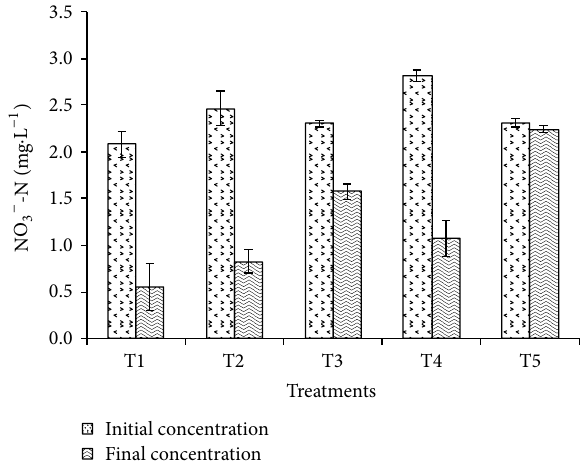
Figure 4: The change of the concentration of NO 3− -N under controlled drainage at jointing-booting stage. The initial and final concentrations are the NO 3 − -N concentration in groundwater at the beginningofsubmergenceandendofdrainage,respectively.Vertical bars represent ± standard error (SE) of the